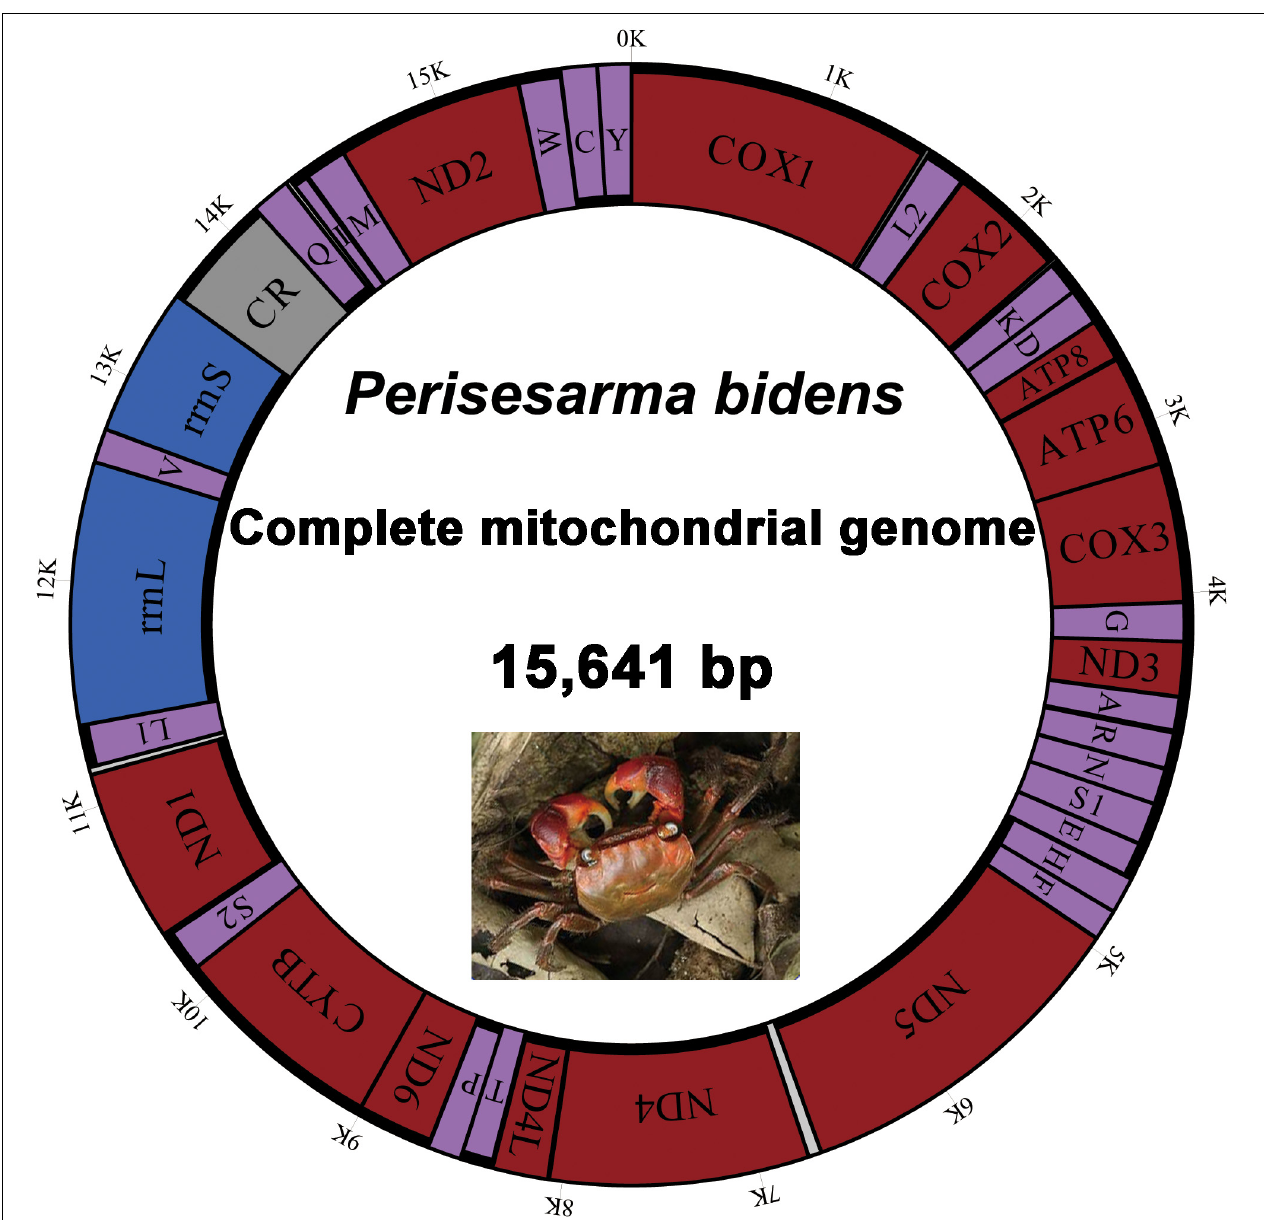
FIGURE 1 | Map of the P . bidens mitogenome. Protein-coding and ribosomal genes are shown with standard abbreviations. Genes for tRNAs are abbreviated by single letters, with S1 = AGN, S2 = UCN, L1 = CUN, and L2 = UUR. CR, control region.